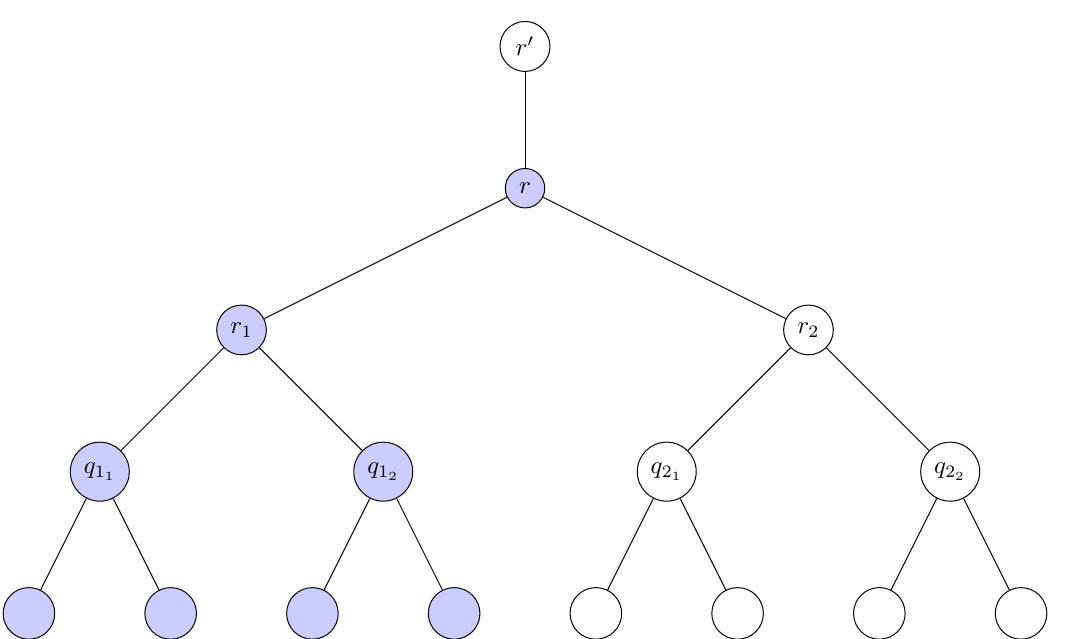
Figure 1: T + : Binary extended tree of height 3 with highlighted 1 st extended subtree of T 2 , 2 , 3